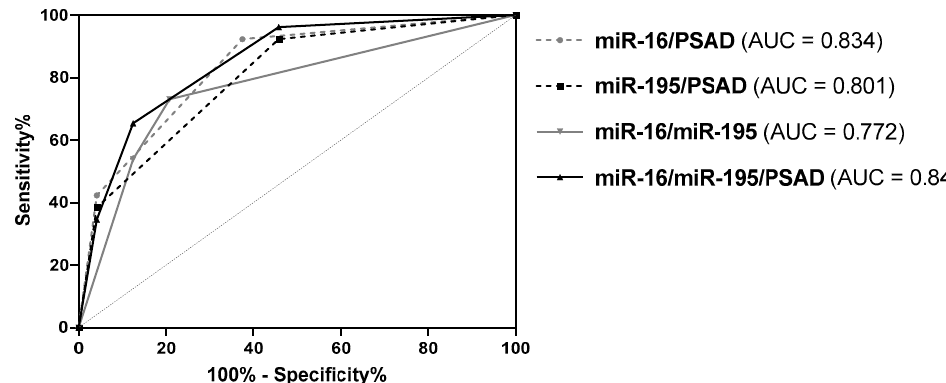
Figure 3. ROC curve analysis of the combinations miR-16 / PSAD, miR-195 / PSAD, miR-16 / miR-195, and miR-16 / miR-195 / PSAD using the whole study cohort ( n = 50).